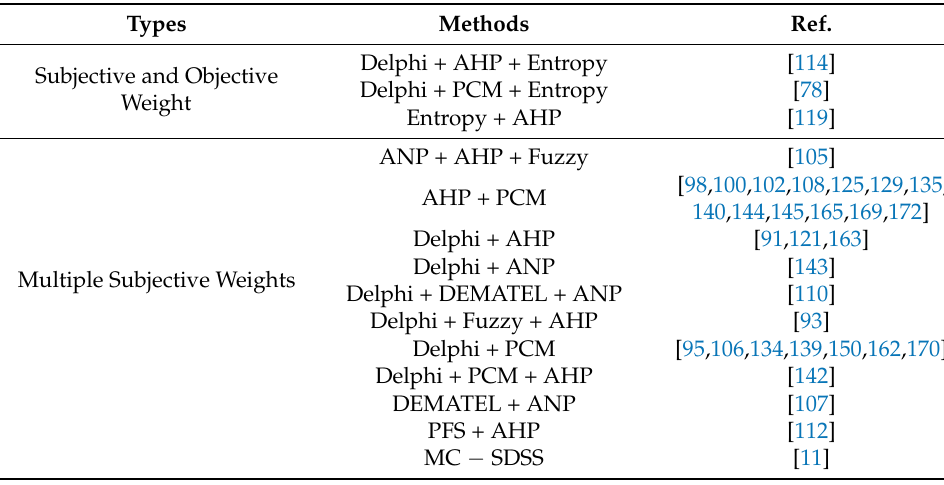
Figure 14. The topic distribution of the proportion of weighting methods. Table 8. Summary of comprehensive weighting methods.